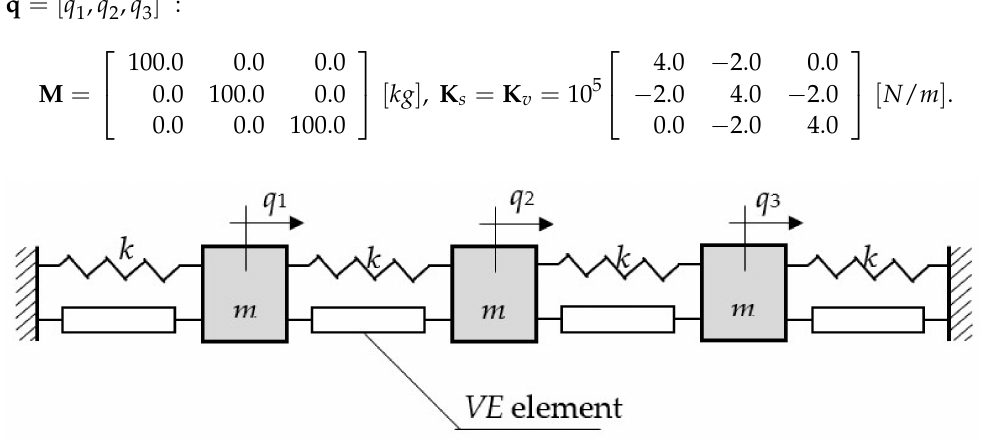
Figure 3. Three-degrees-of-freedom VE